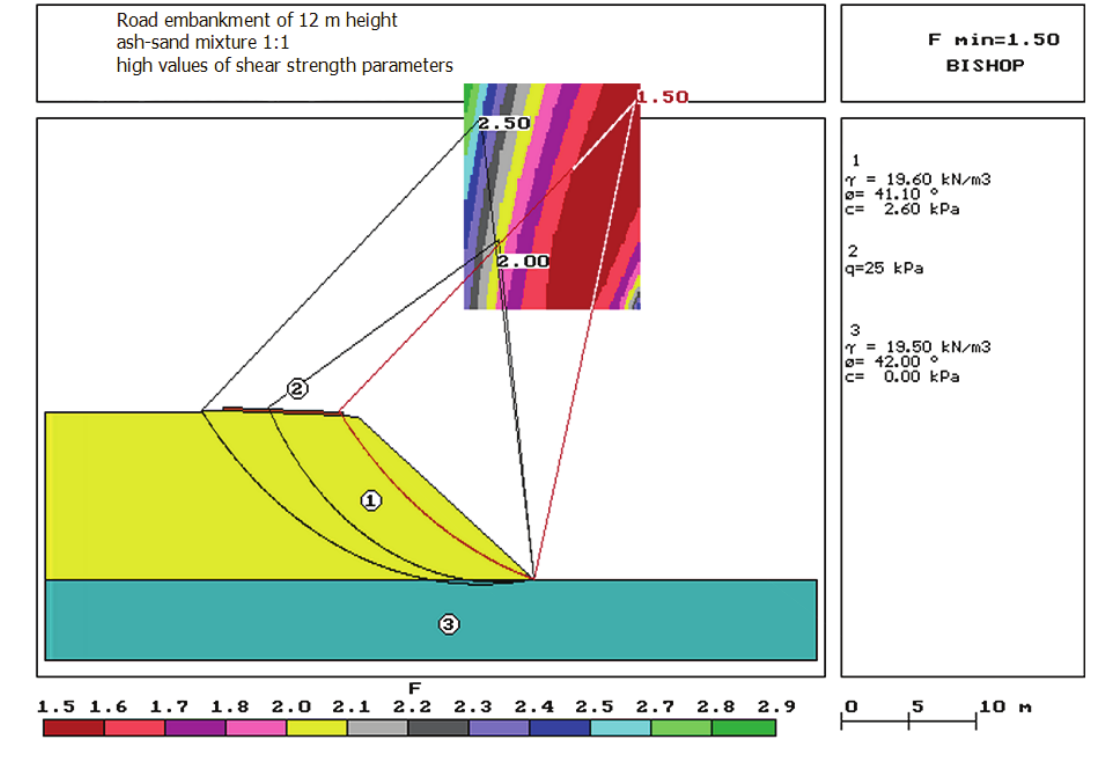
Figure 5: Embankment with the height of 12 m, made of ash-sand mixture.